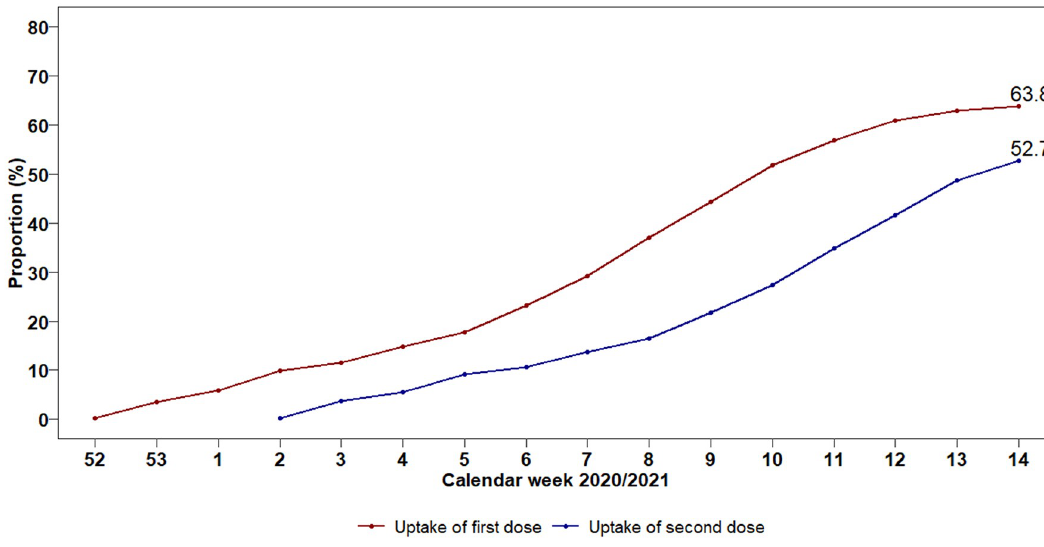
Fig 1. Uptake of BNT162b2 vaccine in persons � 80 years in